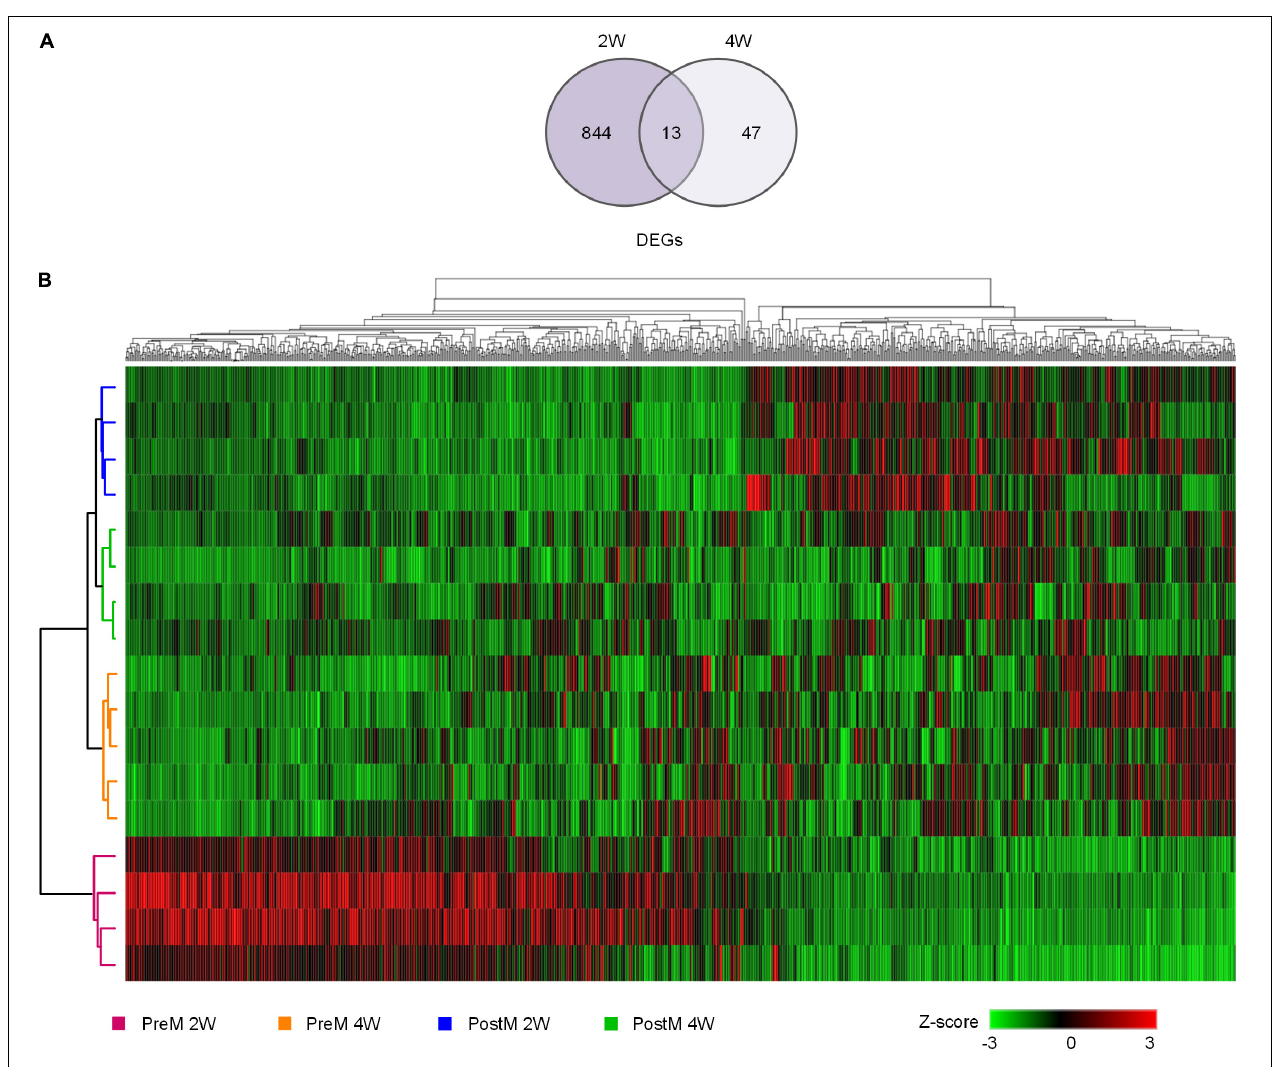
FIGURE 3 | The expression pattern of DEGs in the liver of gnotobiotic mice over time. (A) Venn diagrams of the DEGs between the two groups on week two and week four determined by Deseq2 with the standard of |log2FoldChange| ≥ 1; (B) hierarchical clustering of all the DEGs, with the color of the spot corresponding to the normalized and z -score transformed relative abundance. n = 4 or 5 for each group. DEGs, differentially expressed